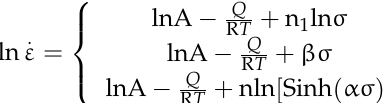
. ε . ε . ε ; ( b ) σ and ln ; ( c ) ln [ sinh ( ασ )] and ln ; ( d ) 1000/T; and ln [ sinh ( ασ )]